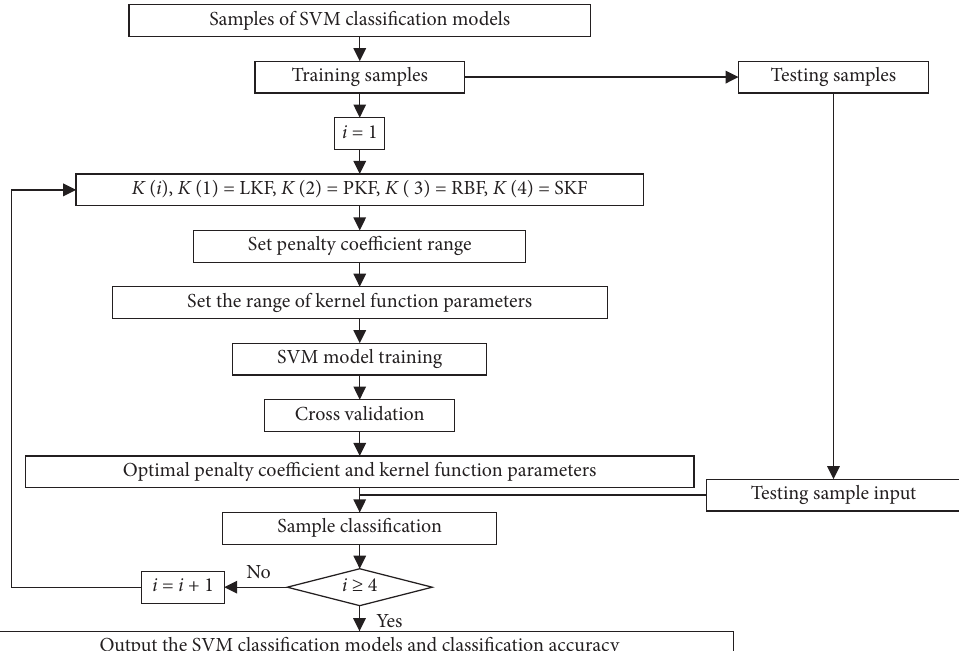
Figure 2: Flowchart of SVM classification